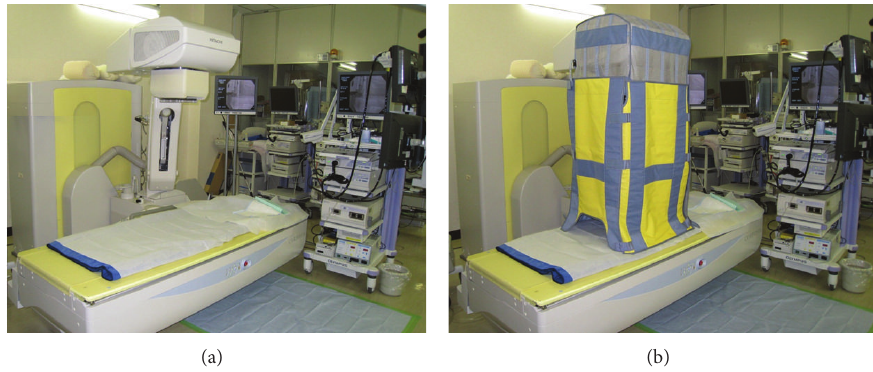
Figure 1: X-ray fluoroscopy generator and protective lead shield. (a) Without protective lead shield. (b) With protective lead shield.